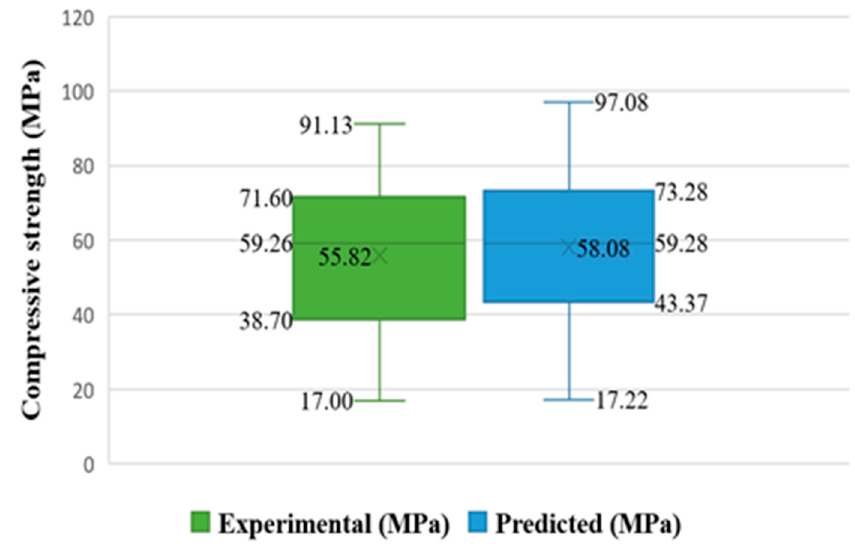
Figure 14. Indication of the error’s difference between the actual and forecasted CS result of SCC from BR model.